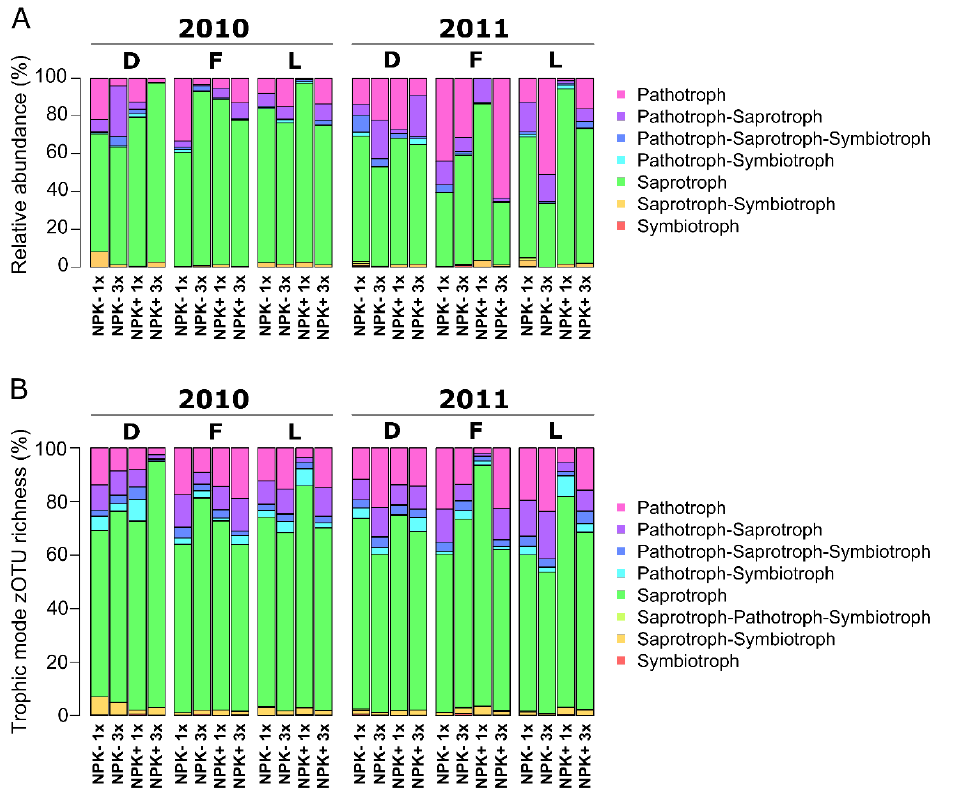
Figure 5. Relative abundance of fungal zOTUs classified by the main trophic modes (A) and proportion of zOTU per trophic mode (B) in 2010 and 2011. The relative abundances of the trophic modes were calculated for each sampling year separately using the FunGuild database and are based on 31.2% of the zOTUs (n = 1009 zOTUs). Abbreviations: D, D. glomerata ; L, L. perenne ; F, F. rubra ; NPK-, no fertilizer application; NPK+, with fertilizer application; 1x, mown once a year; 3x, mown three times a year.